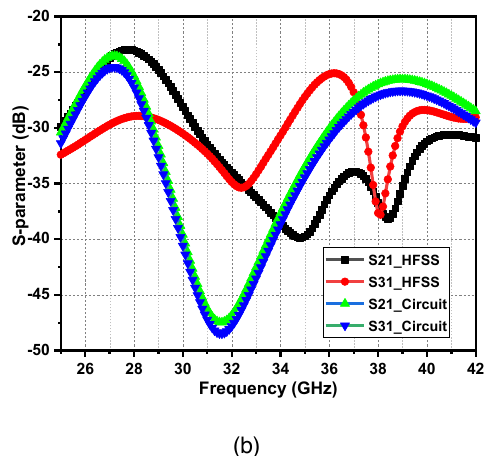
(b) Figure 4. The single antenna reflection coefficient: (a) without/with CSRR and (b) variation of CSRR arm length